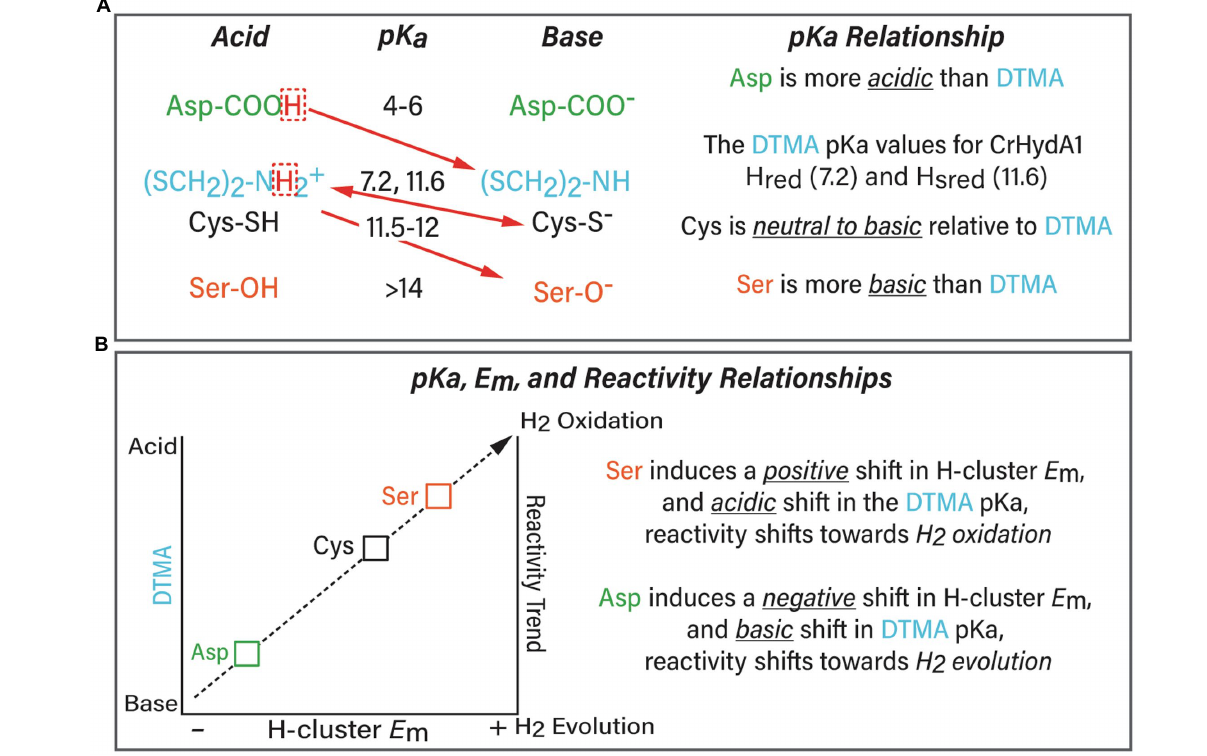
FIGURE 2 | (A) Summary of the relationship between the exchange site pKa (Asp, green; Cys, black; and Ser, orange) and pKa of the H-cluster DTMA ligand (blue). The preferred proton transfer direction is indicated with red arrows. The pKa values for Asp, Cys, and Ser were calculated in this study, and the measured pKa values for the bridging ligand di(thiolmethyl)amine (DTMA, blue) were taken from (Sommer et al., 2017; Birrell et al., 2021) for CrHydA1. The scaling model predicts that Asp induces a basic shift whereas Ser induces an acidic shift in DTMA pKa, this would create an even more favorable direction bias than indicated in the Figure. (B) Summary of the model of the pKa, E m , and reactivity relationships based on the results of this